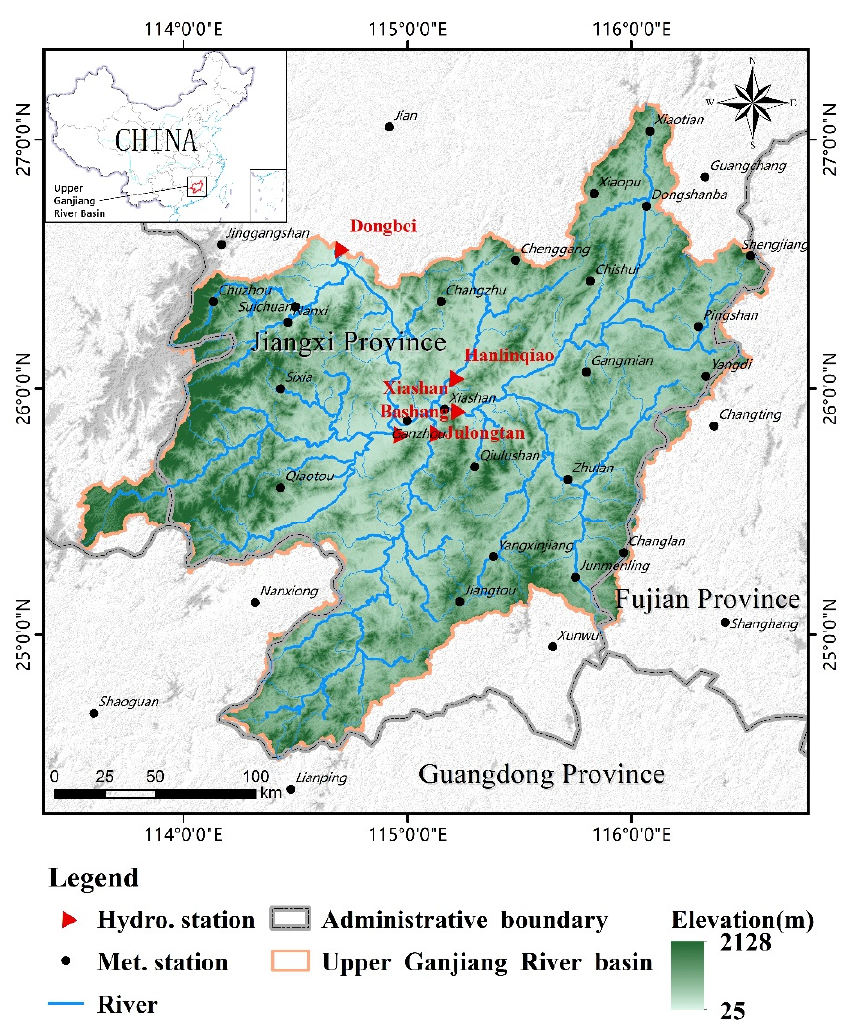
Figure 1. The position of the upper Ganjiang River basin and the distribution of hydrological and meteorological